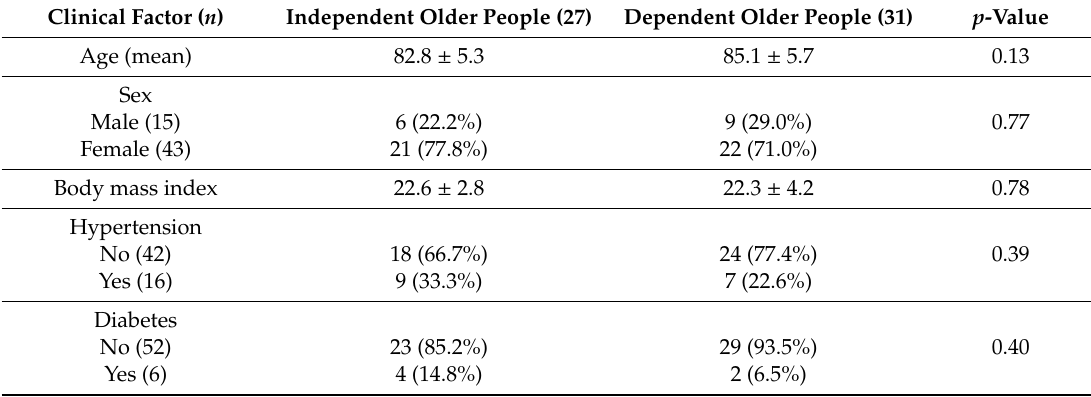
Table 1. Clinical characteristics of independent and dependent older